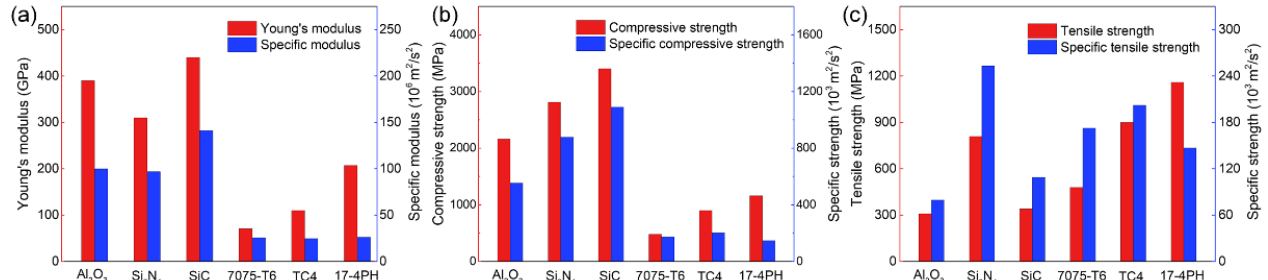
Figure 1. Comparison of materials’ mechanical and load-bearing properties. ( a ) Young’s modulus vs. specific modulus; ( b ) Compressive strength vs. specific compressive strength; ( c ) Tensile strength vs. specific tensile strength.